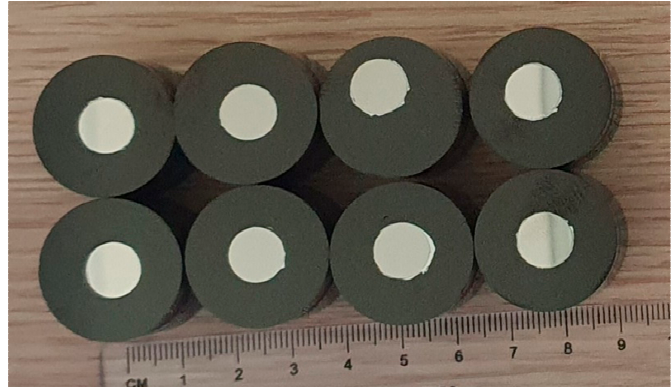
Figure 3. 316 L SS samples immersed and mounted for further study.